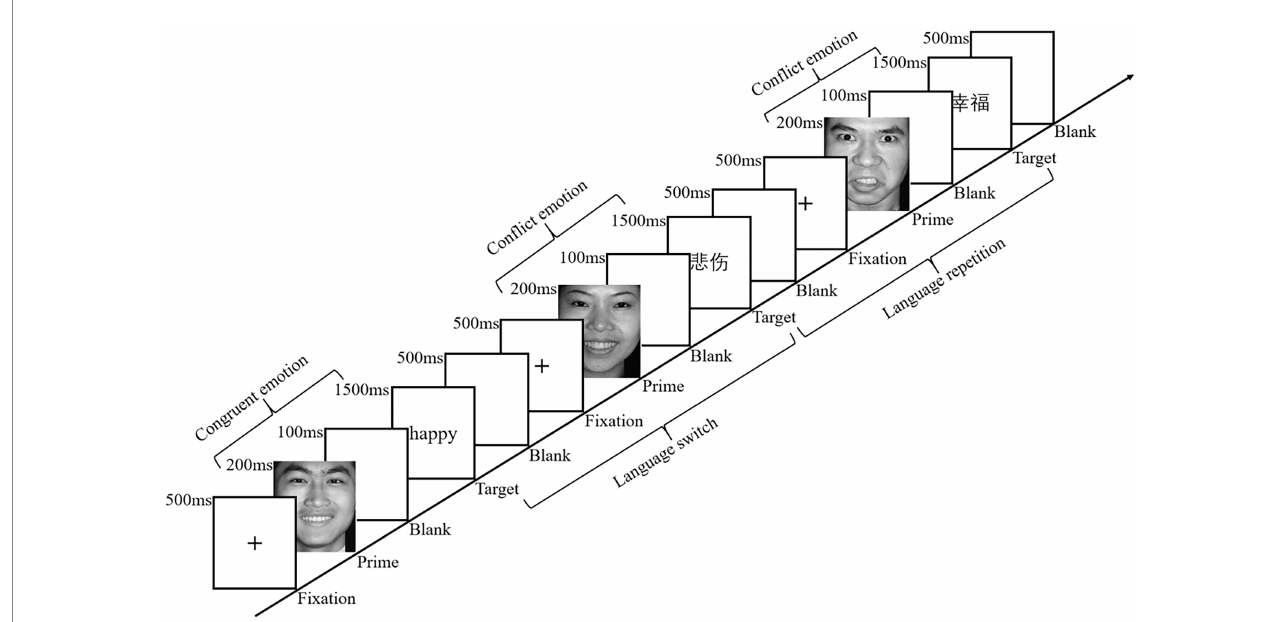
FIGURE 1 Flowchart of three experimental trials. Reproduced with permission from Yaojia Luo. Facial images reproduced with permission from Gong et al. (2011).